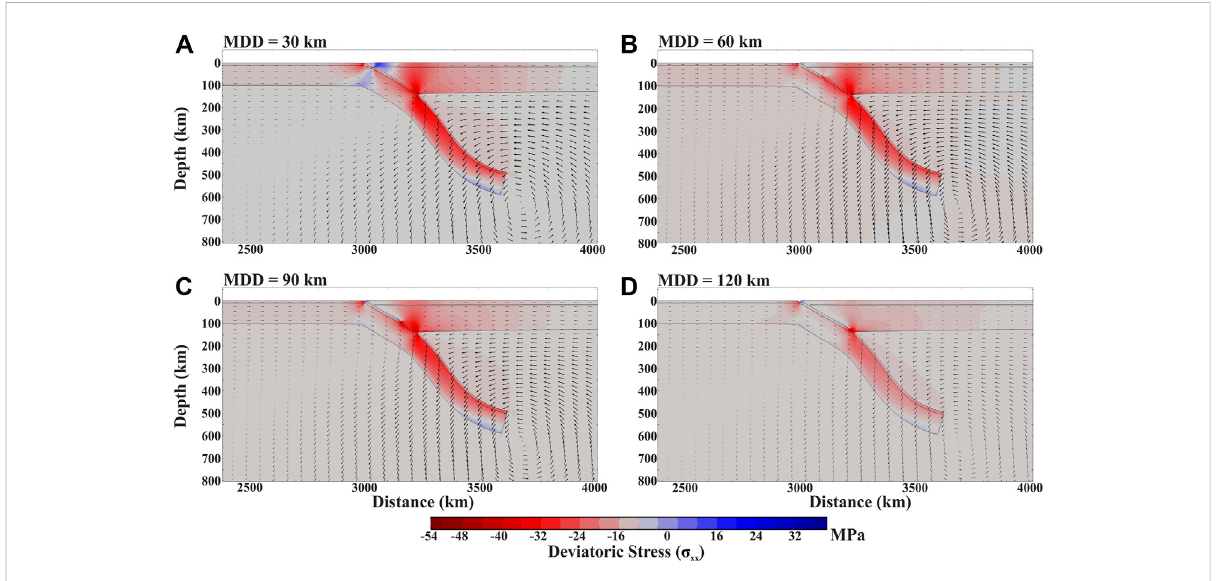
FIGURE 8 (A – D) Deviatoricstress fi eldsofsubductionzonesforvaryingMDDinthesimulationexperiments.Modelruntime:10Myr.Negativeandpositive stress values represent compressional and extensional stresses, respectively. Arrows show the fl ow velocity